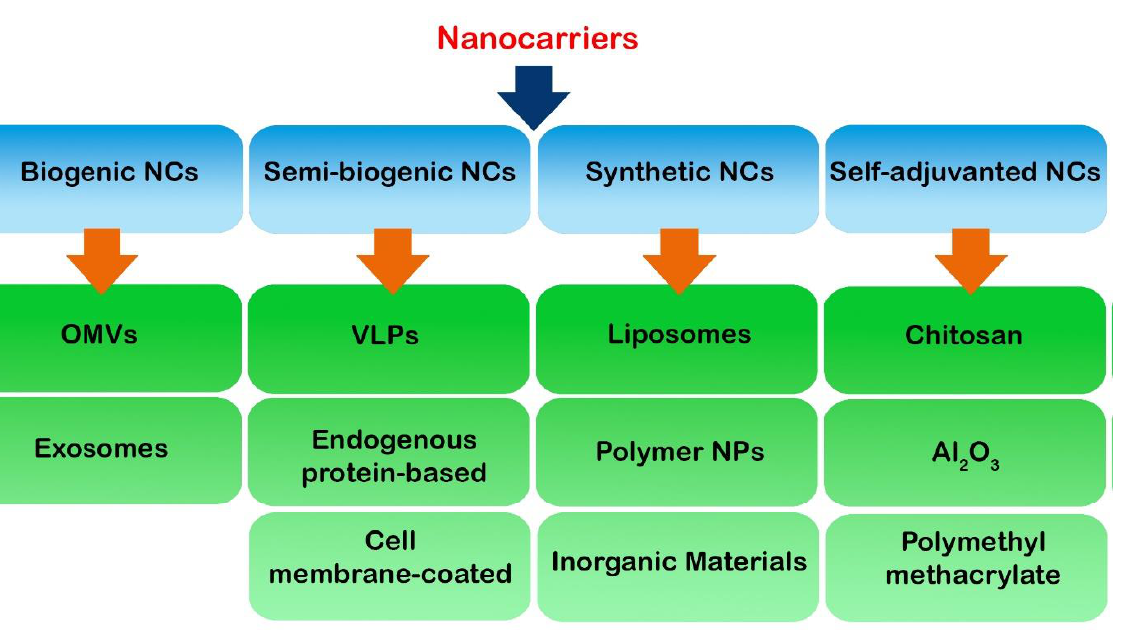
Figure 2. Three main nanocarriers are shown, including biogenic, semi-synthetic and synthetic NCs. NP: nanoparticle; NC: nanocarrier; OMV: outer membrane vesicles; VLP: virus-like particle .